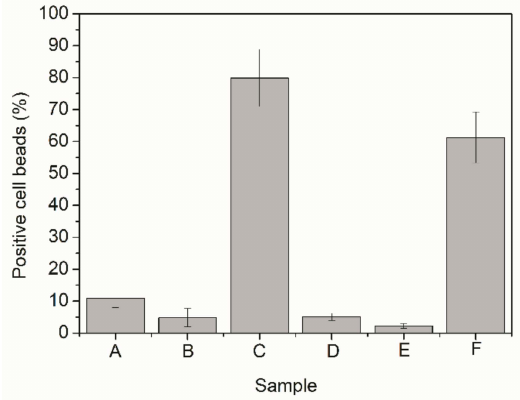
Figure 11. Cellular uptake of polymer particles bioconjugated with